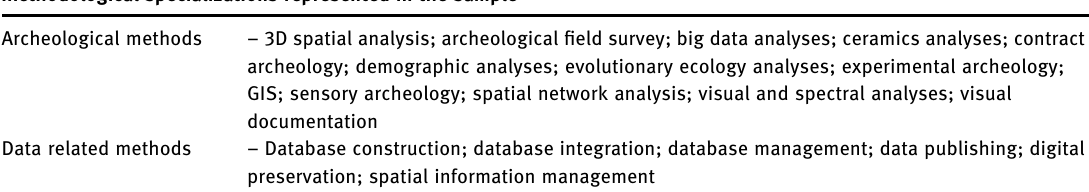
Table 2: Methodological specializations represented in the sample, thematic overview Methodological specializations represented in the